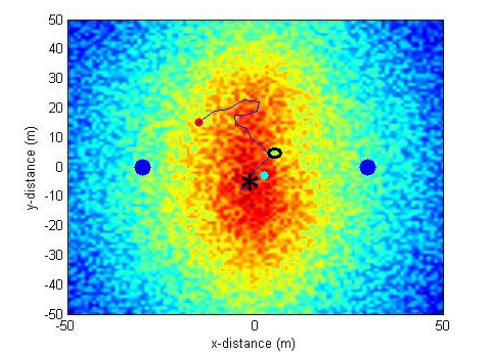
Figure 13. A sample simulation using SNR measurements for the LOS scenario with 2-dBm Gaussian RSS noise and a localized external noise source. The theoretical optimum is indicated as *. ( a ) Map of SNR values. Server node at ( − 30,0), client node at (30,0) and a localized noise source at (5,5); ( b ) Path taken by the relay node in reaching the global optimum overlaid on the objective function